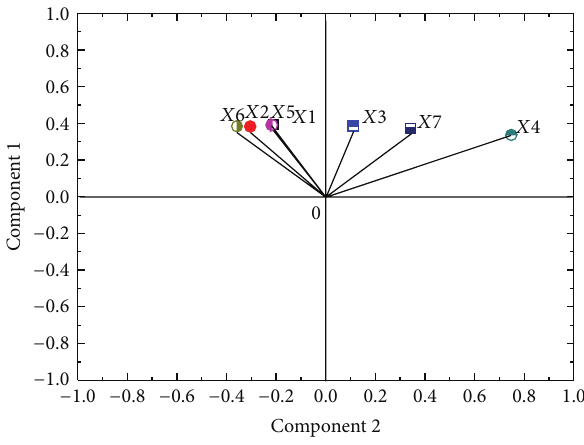
Figure 6: Loading plot of principal components.